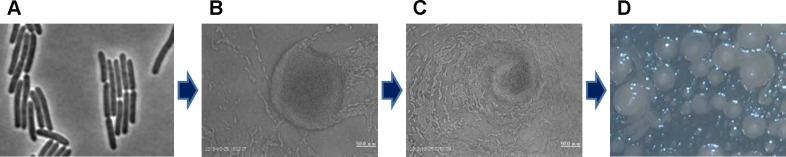
Progression of motility on 1.5% agar media.After inoculation, Paenibacillus sp. formed small clusters of cells (A), which grew up to visible tiny colonies. These colonies then moved around actively at speed 3.6 μm sec-1 (B). When the colony density became high, colonies began to rotate in a vortex like formation (C). The rotation speed of the vortices gradually decreased and finally static round colonies were formed (D). The photographs are not to scale.